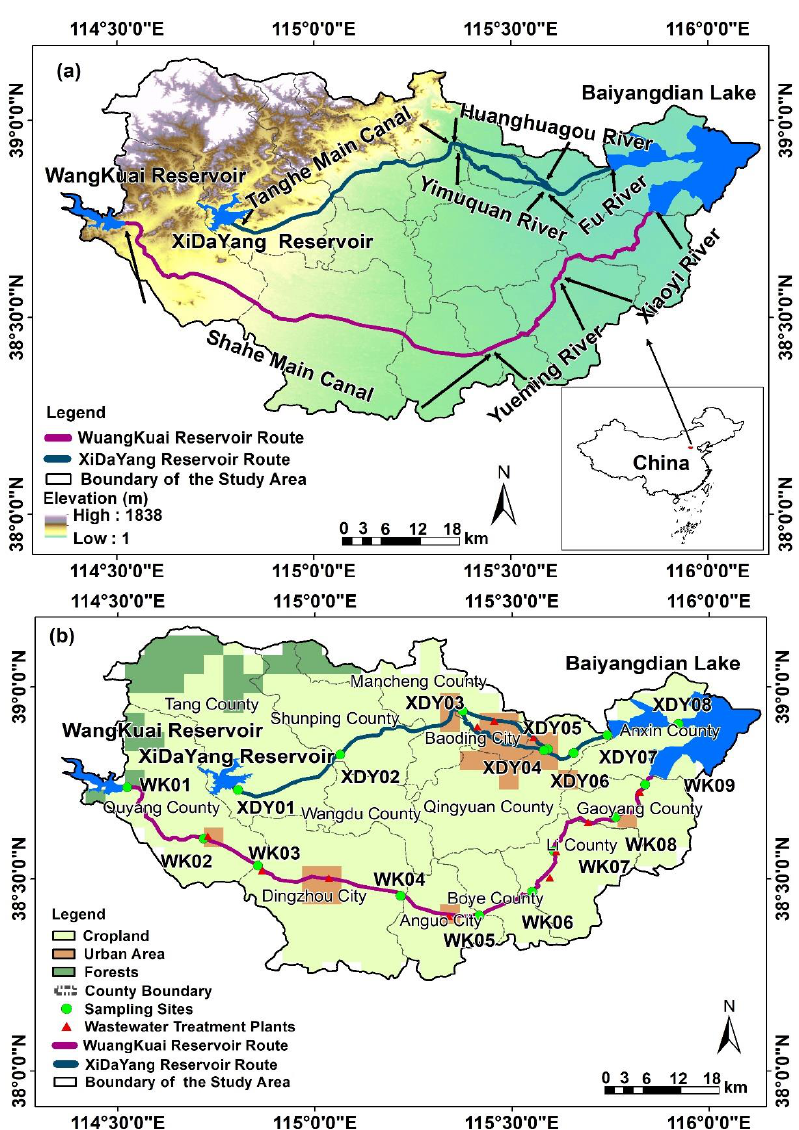
Figure 1. ( a ) Topography and river system and ( b ) sampling sites, outlet of waste water treatment plants and land use in 2015 derived from Moderate-Resolution Imaging Spectroradiometer remote sensing data along the routes of environment flow allocations from Wangkuai and Xidayang Reservoirs to Baiyangdian Lake.